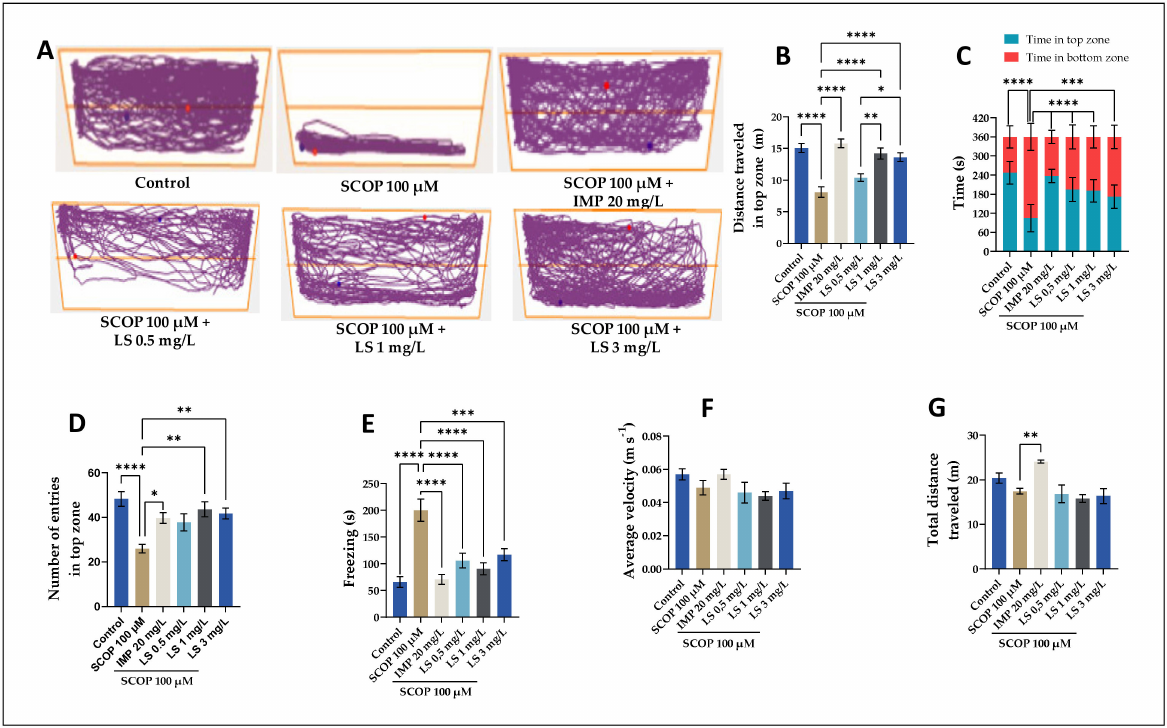
Figure 5. Lycopodium selago hydroethanolic extract (LS: 0.5, 1, and 3 mg/L) improved the locomotion pattern and reduced anxiety in the novel tank-diving test (NTT). ( A ) Representative locomotion-tracking pattern in different groups. ( B ) Repre- sentation of the distance traveled in the top zone in different groups. ( C ) The time spent by zebrafish in the top/bottom zone of the tank in different groups. ( D ) Representation of the number of entries in the top zone by zebrafish in the tank in different groups. ( E ) Representation of the freezing activity by zebrafish in the tank in different groups. ( F ) Representation of the average velocity of zebrafish in the tank in different groups. ( G ) Representation of the total distance traveled by zebrafish in the tank in different groups. Values are means ± S.E.M. ( n = 10). For Tukey’s post-hoc analyses: **** p < 0.0001, *** p < 0.001, ** p < 0.01, and * p <